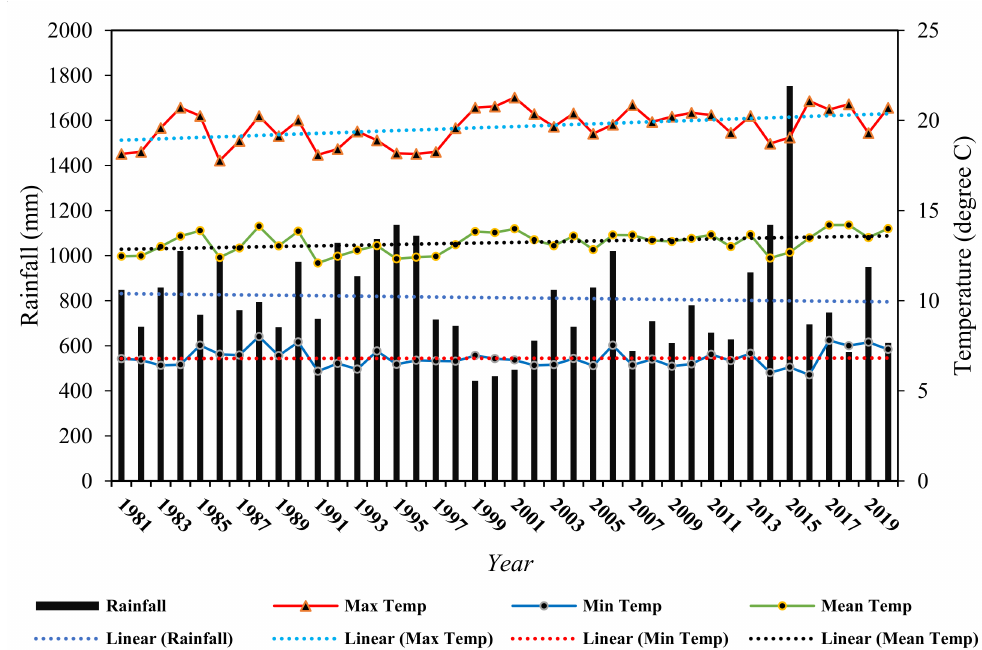
Figure 3. Annual temperature (T mean , T min , and T max ) and precipitation at Shalimar station located in Srinagar (SKUAST-Met